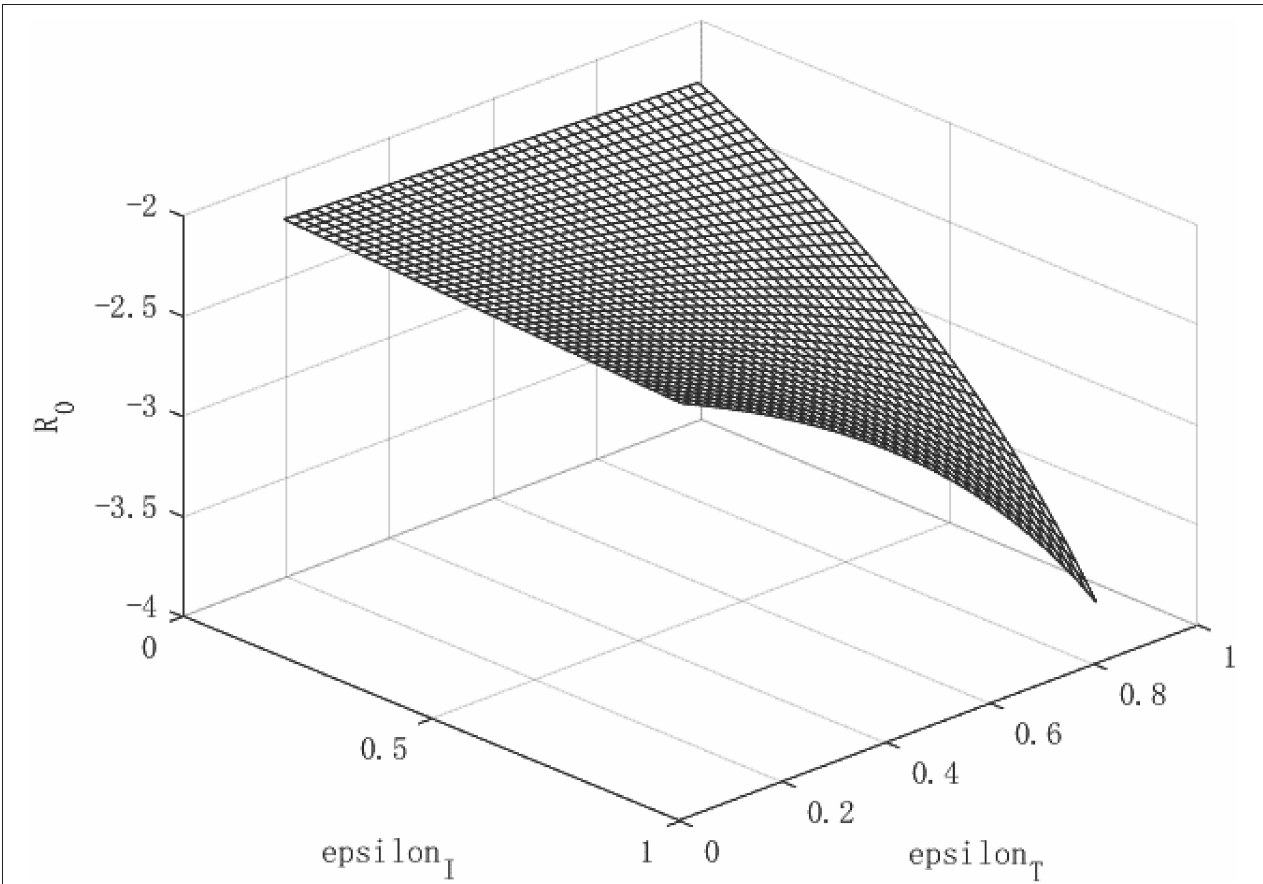
FIGURE 7 | Virus Transmission Path of high contagious public health